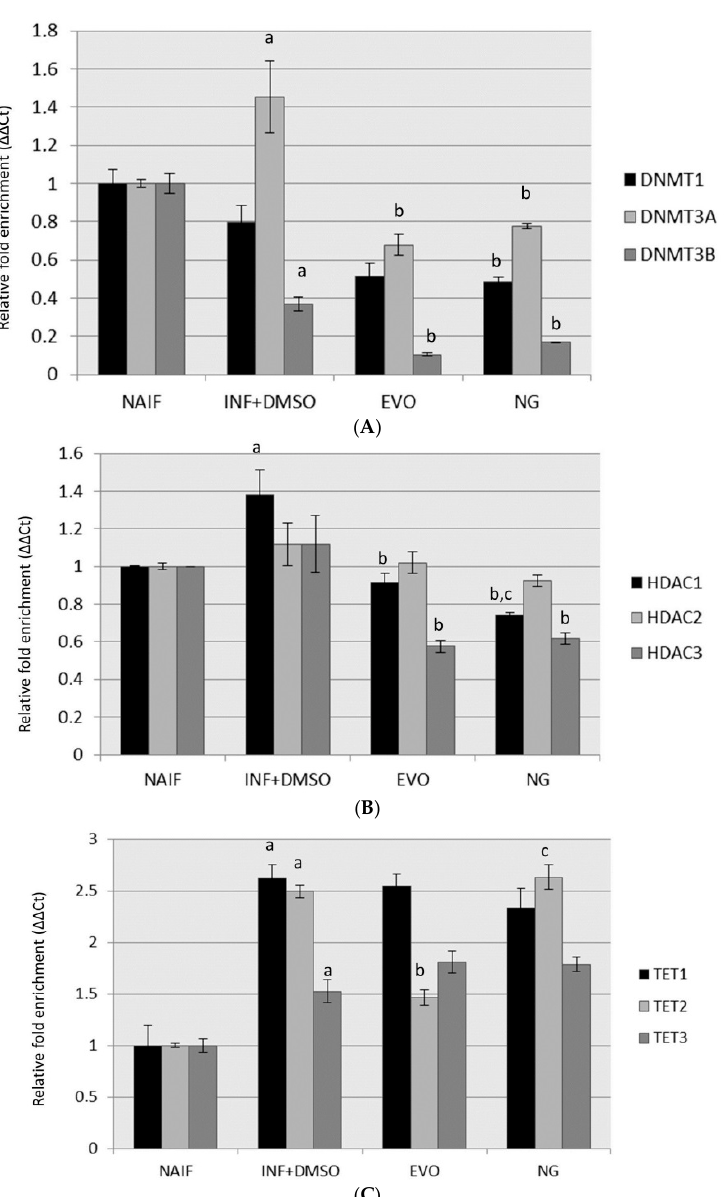
Figure 4. Gene expression assessment after the treatments in experimental setting 2 (SET2) for ( A ) genes regulating DNA methylation; ( B ) genes regulating histone acetylation; ( C ) genes associated with DNA demethylation. Statistically significant differences are indexed as follows: a = vs. NAIF; b = vs. INF + DMSO; c = vs. EVO.